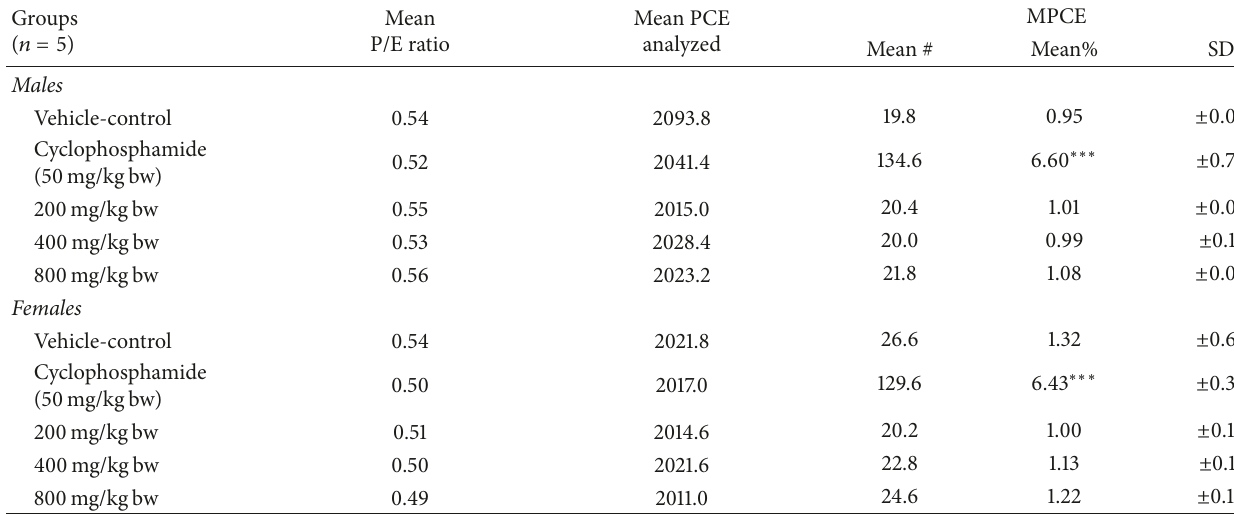
Table 7: Summary results of the micronucleus